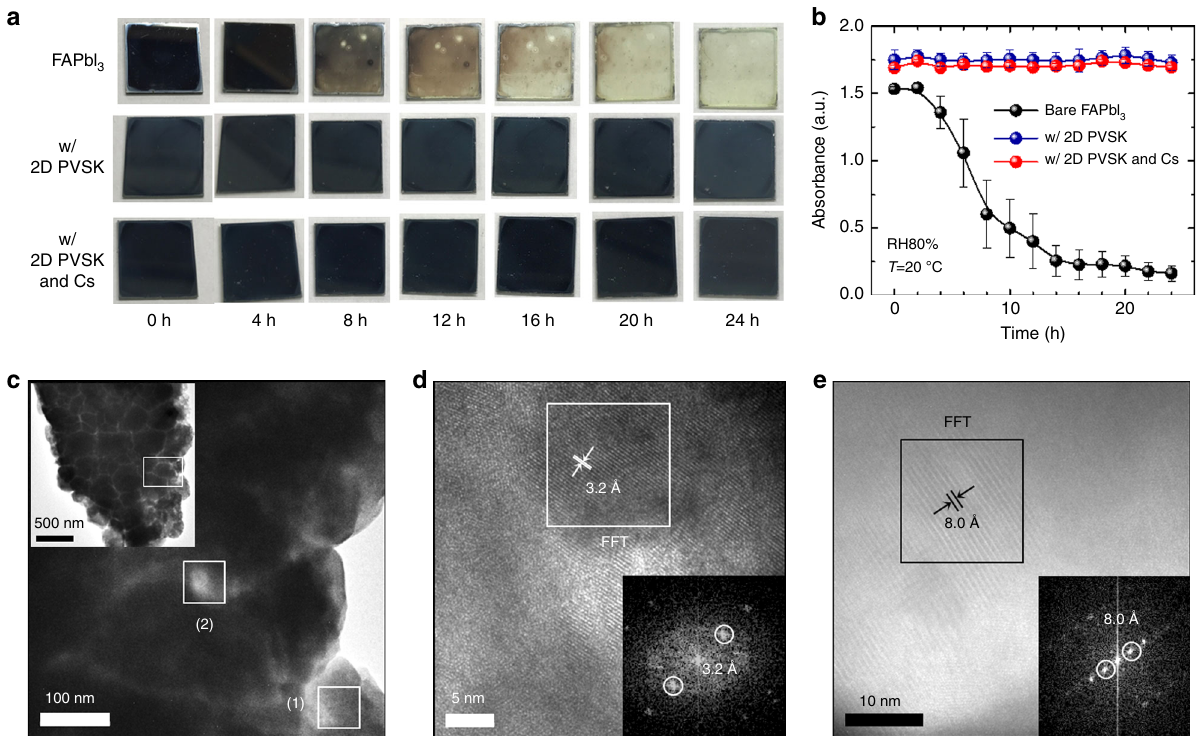
Fig. 3 Improved moisture stability with 2D perovskite at grain boundaries. a Photos of the perovskite fi lms incorporating bare FAPbI 3 , FAPbI 3 with 2D perovskite and FA 0.98 Cs 0.02 PbI 3 with 2D perovskite exposed to relative humidity (RH) of 80 ± 5% at 20 ± 2 °C for different time. b Evolution of absorption of the fi lms at 600 nm under RH 80 ± 5% at 20 ± 2 °C. The error bar indicates standard deviation of the absorbance measured from three fi lms for each condition. c – e Transmission electron microscopic (TEM) images of the FA 0.98 Cs 0.02 PbI 3 fi lm with 1.67 mol% PEA 2 PbI 4 . Inset of c demonstrates the lower magni fi cation image showing the polycrystalline nature with grain boundaries. The highlighted area (1) and (2) were investigated in d and e , respectively. Inset of d and e show Fast Fourier transform (FFT) analysis of the area within boxes,